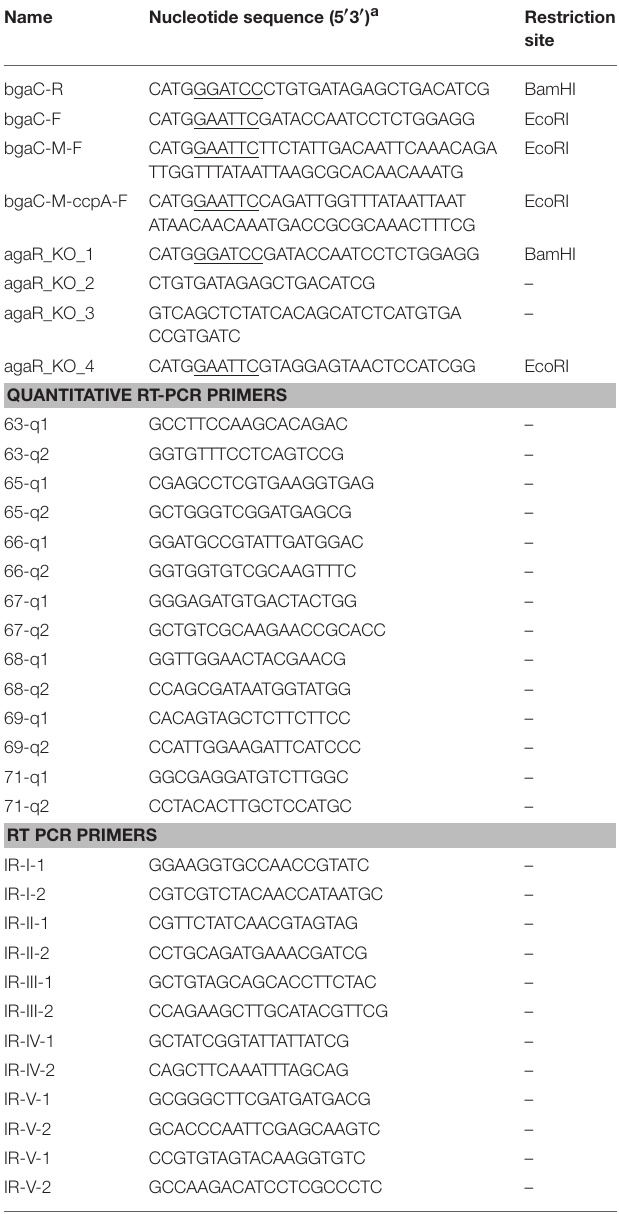
TABLE 2 | List of primers used in this